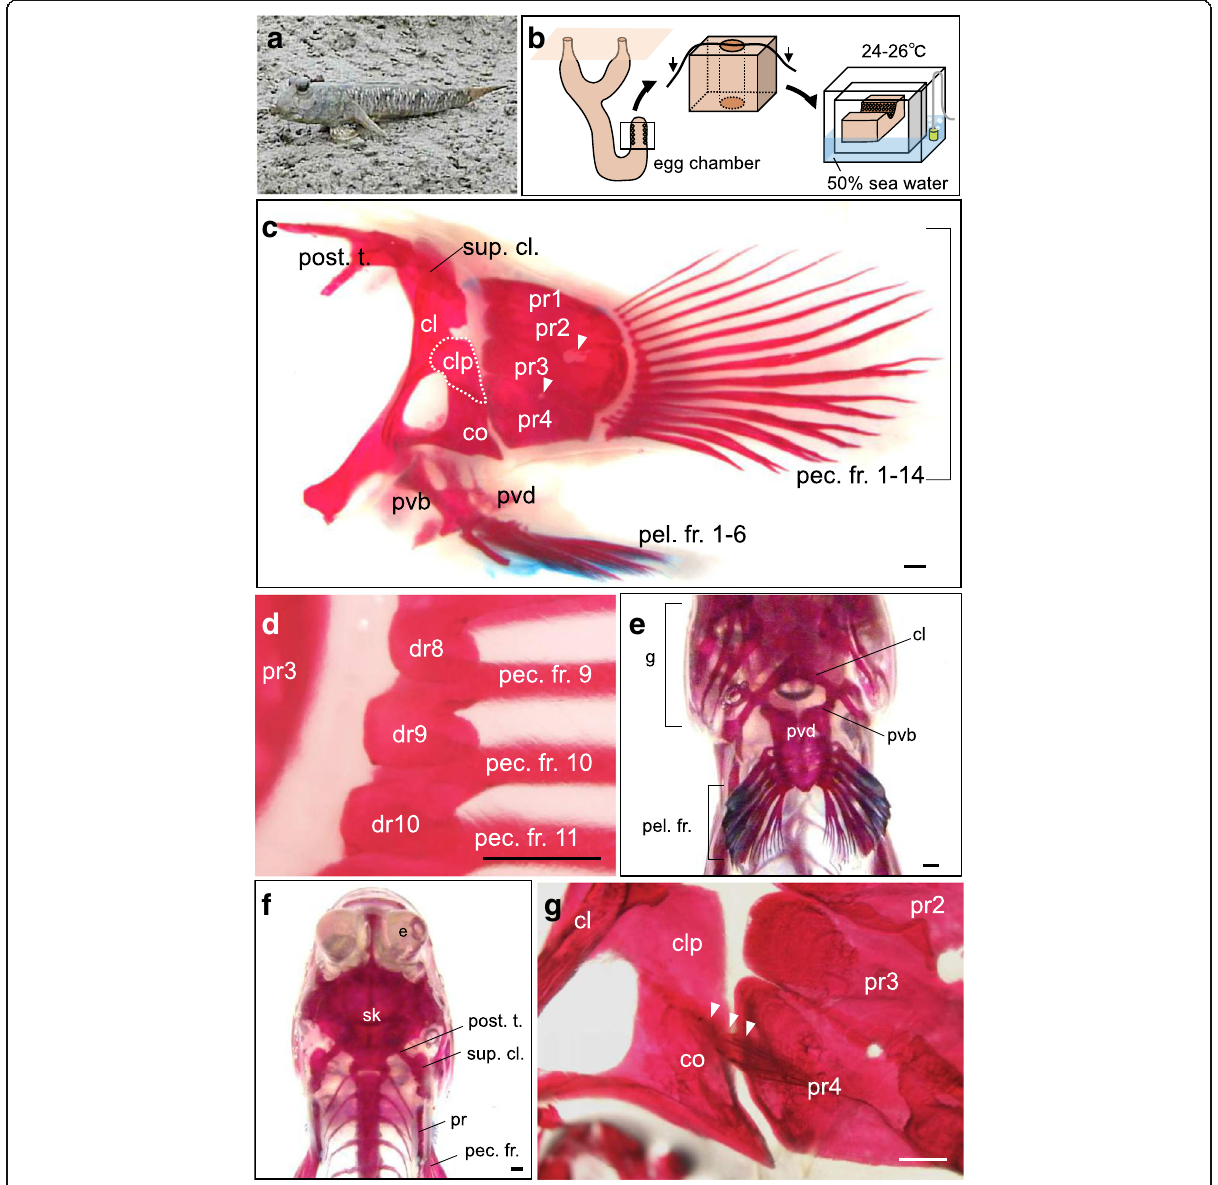
Fig. 1 Collection of samples and the pectoral fin of an adult mudskipper Ps. modestus . a The adult mudskipper ( Periophthalmus modestus ). b The egg chamber and surrounding mud was excavated, transferred to a humid container, and brought back to the laboratory. The open container was set adrift in an aerated aquarium kept within an incubator. c – g Skeletal patterns of an adult mudskipper ( n = 1). c Lateral view of the pectoral fin of an adult mudskipper. Arrowheads indicate inter-radial fenestrae. d Ventral view of the medial part of the pectoral fin. e , f Ventral ( e ) and dorsal ( f ) views of the thoracic region of an adult mudskipper. g Ventral view of the proximal part of the pectoral fin. The fourth proximal radial partially articulates with the coracoid (arrowheads). cl, cleithrum; clp, cleithrum plate; co, coracoid; dr1 – 14, distal radials 1 to 14; e, eye; g, gill; pec. fr. 1 – 14, pectoral fin rays 1 to 14; pel. fr. 1 – 6, pelvic fin rays 1 to 6; post. t., posttemporal; pvb, pelvic bone; pr1 – 4, proximal radials 1 to 4; pvd, pelvic dome; sk, skull; sup. cl., supracleithrum. Scale bars, 1